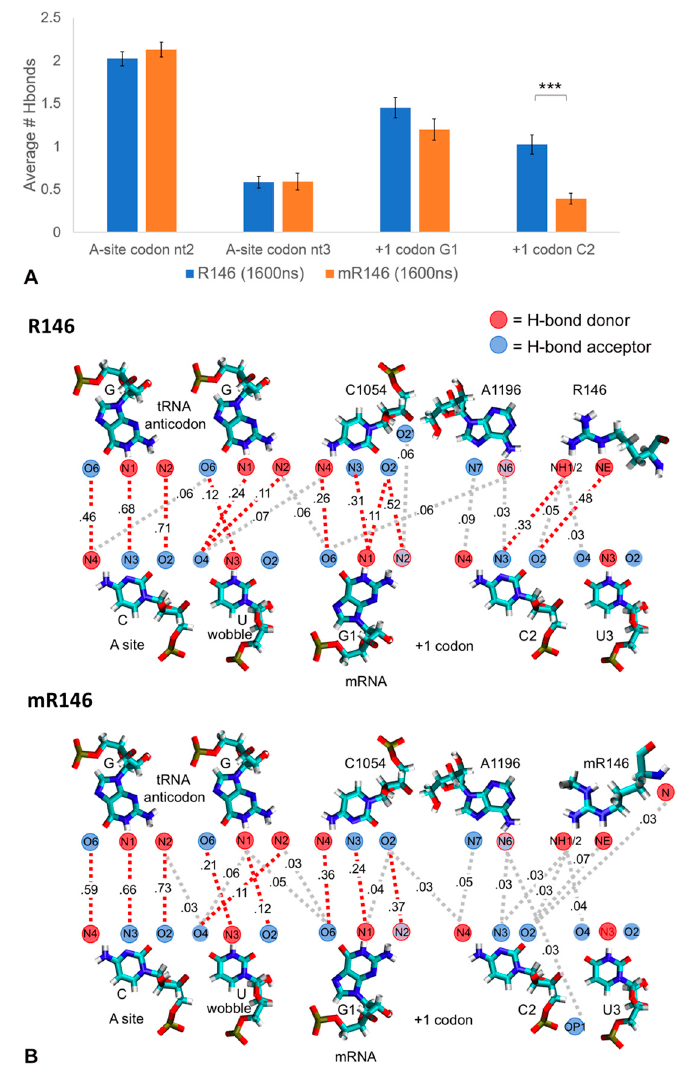
Figure 4. R146 methylation reduces CAR/+1 codon H-bonding. H-bond interactions were quantitated for the A-site nucleotides 2 and 3 and the three +1 codon nucleotides with unmethylated (1.6 μ s) and methylated (1.6 μ s) R146. All hydrogen bonds were counted between these residues and the anticodon and CAR residues (e.g., interactions of C2 with C1054, A1196 and R146). ( A ) Overall H-bond counts show significantly depressed H-bonds for the second nucleotide of the +1 codon (C2) comparing methylated and unmethylated R146 trajectories ( t -test p < 0.001 ***). ( B ) Illustrated are all H-bond interactions with frequencies f : 0.025 < f < 0.095 (grey dashes) or f > 0.095 (red dashes). This reveals depressed H-bond interactions for methylated R146 compared to